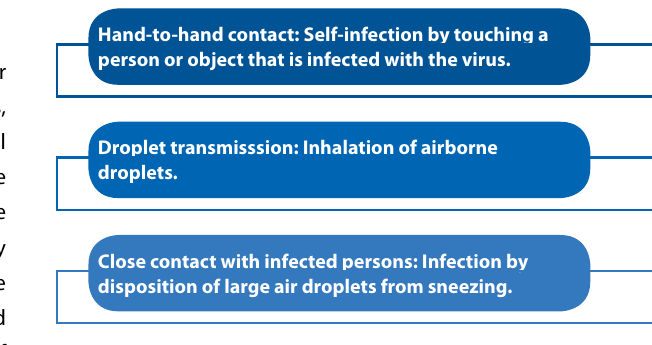
Figure 1: Transmission of viruses that cause colds 2